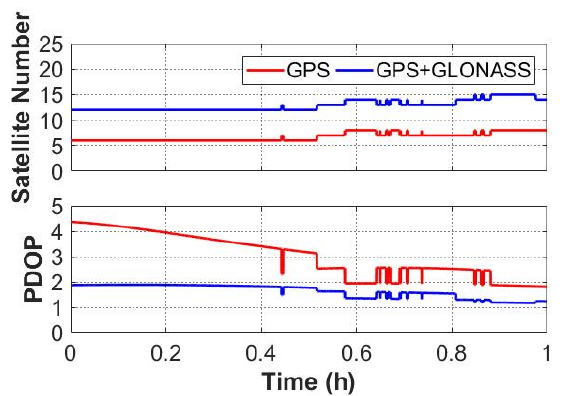
Figure 4. The number of the observed Global Positioning System (GPS) and GLObal NAvigation Satellite System (GLONASS) satellites ( top ) and PDOP values ( bottom ).